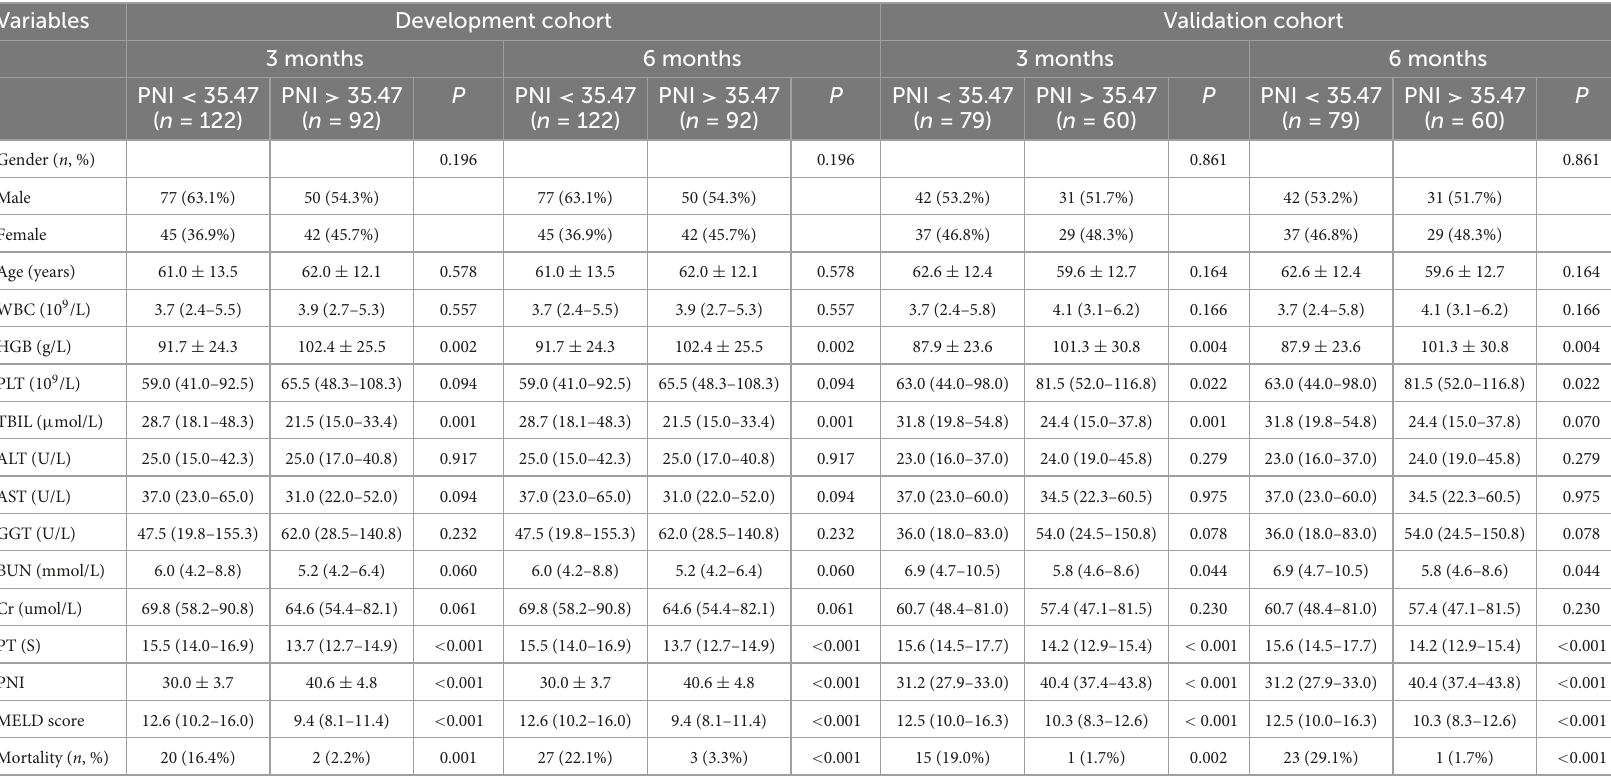
TABLE 2 Comparison of clinical and laboratory characteristics between low and high PNI groups in the development and validation cohort in patients with decompensated liver